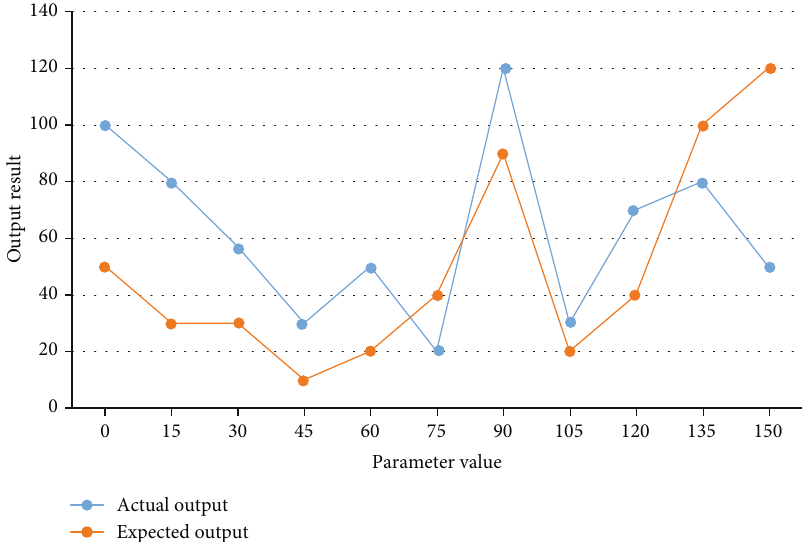
Figure 6: Comparison of the fi tting results between the actual output of the training sample and the expected output value.